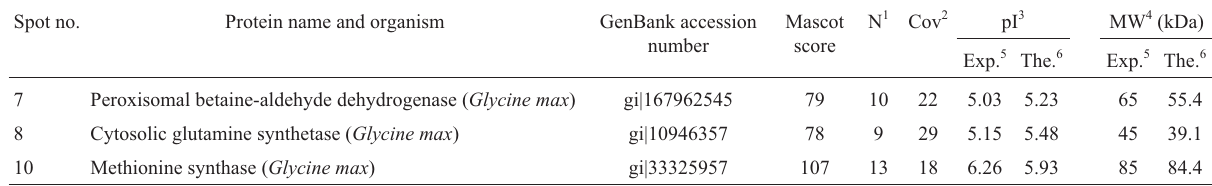
Table 2 - Selected protein spots identified by MALDI-TOF. Spot no.